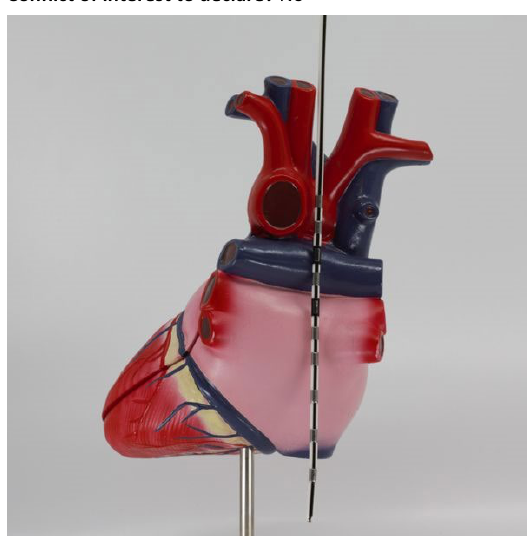
Fig 1: Our 3-dimentional esophageal ECG-probe, with 8 ring electrodes and 2 split electrodes (electrode number 3 and 5 when counting from top to bottom) for 3D recording.